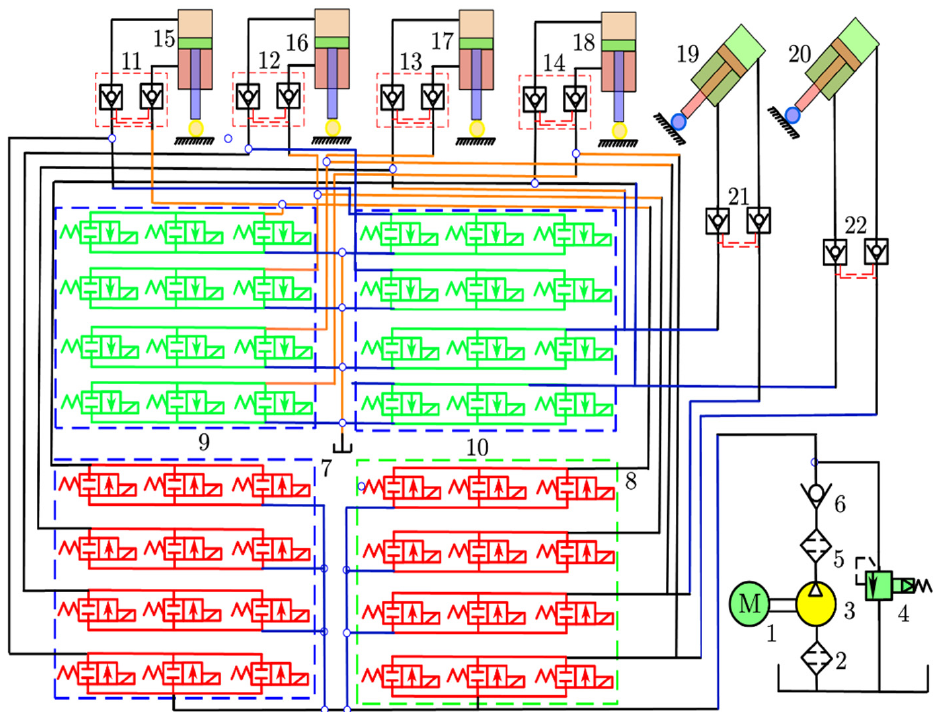
Figure 4. Hydraulic system of new coal gangue conveying equipment. 1. Electric motor. 2. Filter. 3.